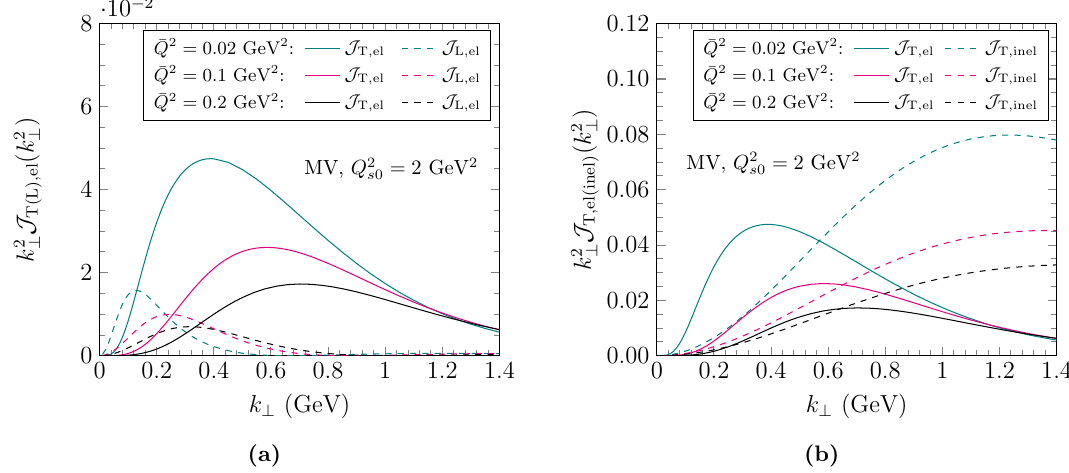
Figure 2. (a) Comparison between the elastic cross-sections in the longitudinal and the transverse sector, respectively. The (reduced) cross-sections multiplied by k 2 for k ⊥ ≤ Q s 0 and several values ¯ Q 2 (cid:28) Q 2 the MV model. (b) Comparison between the elastic and inelastic cross-sections in the transverse sector. Elastic scattering dominates for low enough k ⊥ , shows a maximum around k 2